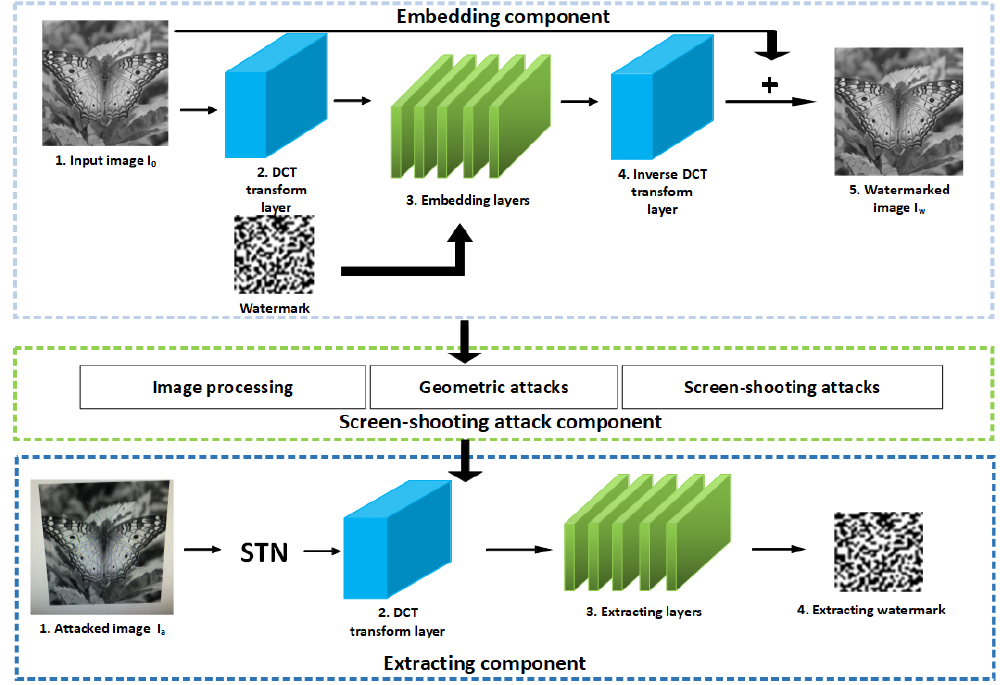
Figure 2. The flowchart of the SSDeN framework.